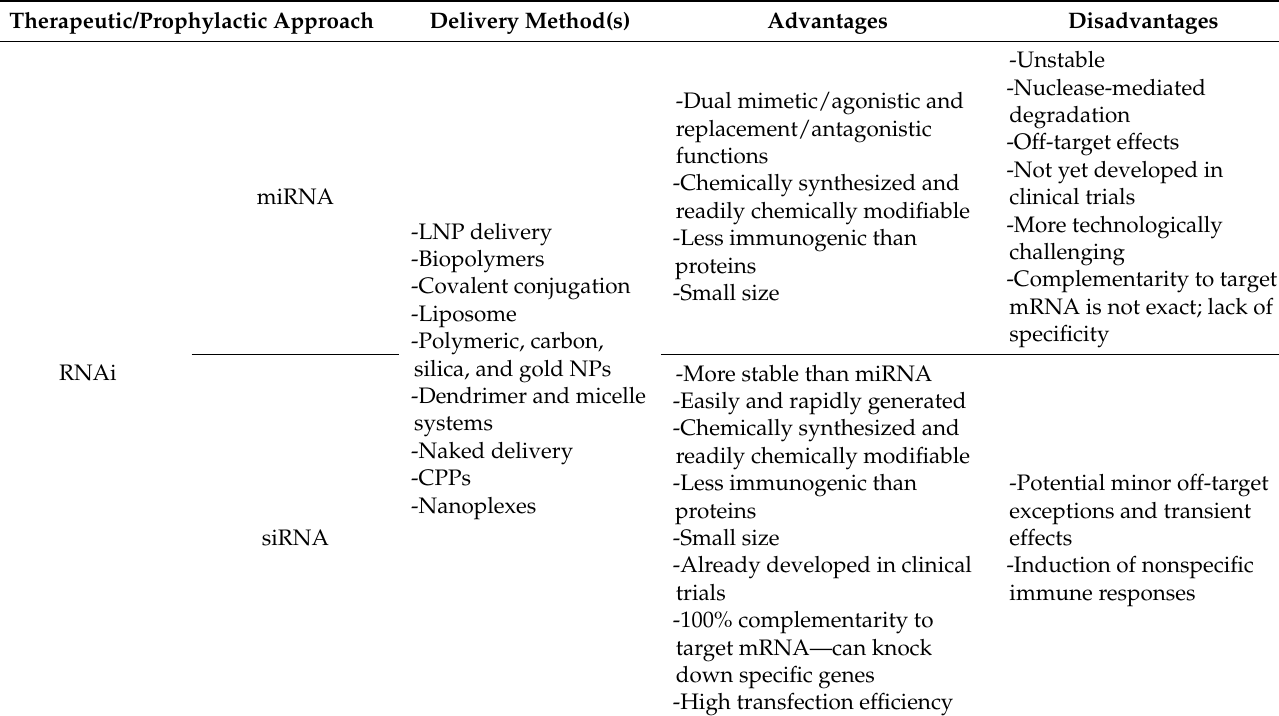
Table 5. Overview of major RNA-based therapeutic methods, main delivery mechanisms, and perceived advantages and disadvantages